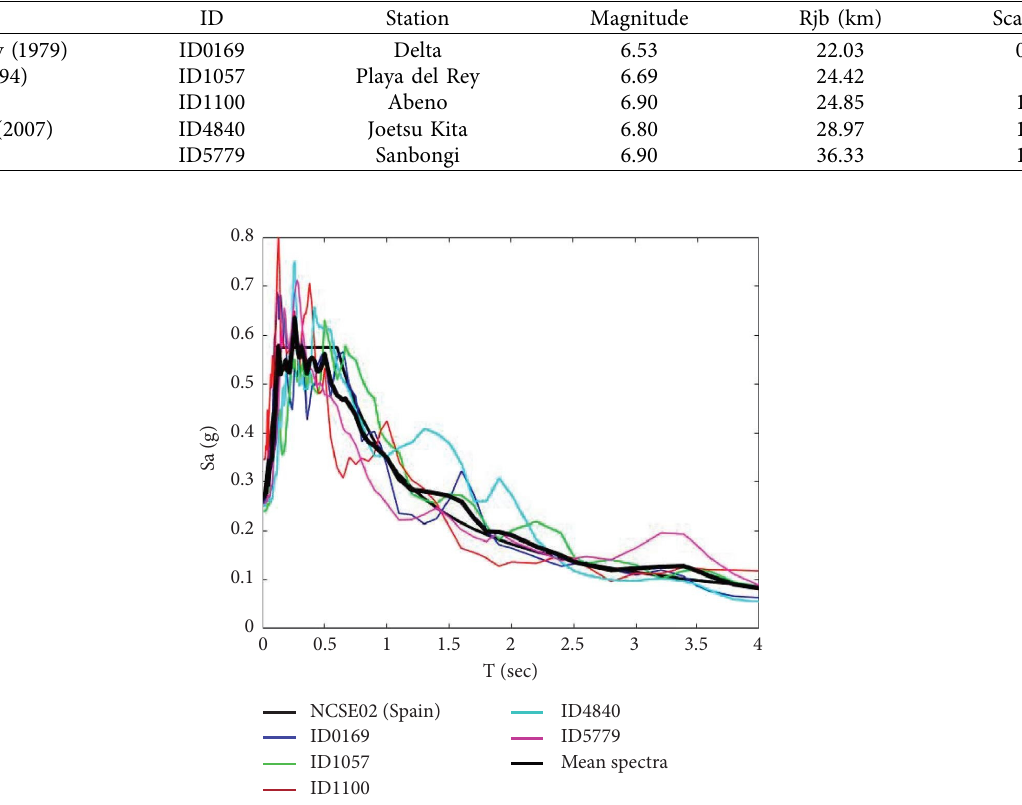
Figure 6: Scaled spectra, mean spectrum, and design spectrum.